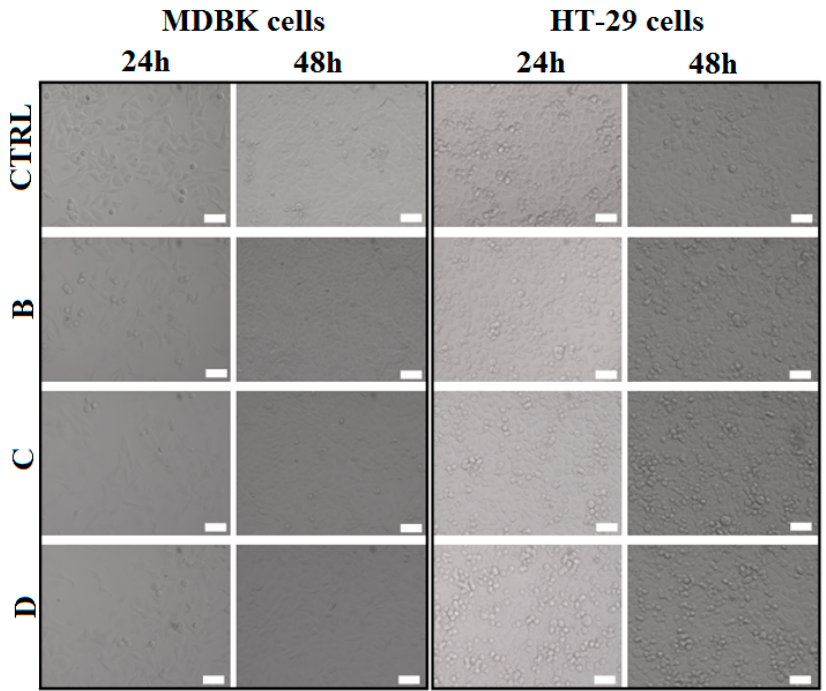
Figure 10. Brightfield images (20×) obtained with automated live microscopy imaging system of MDBK and HT-29 cells incubated for 24 and 48 h with or without different biopolymer-modified clays (B-PMAA-Cl 93A, C-PMAA-Cl 93A-C8, D-PMAA-Cl 93A-C18). Scale bar 50 μ m.